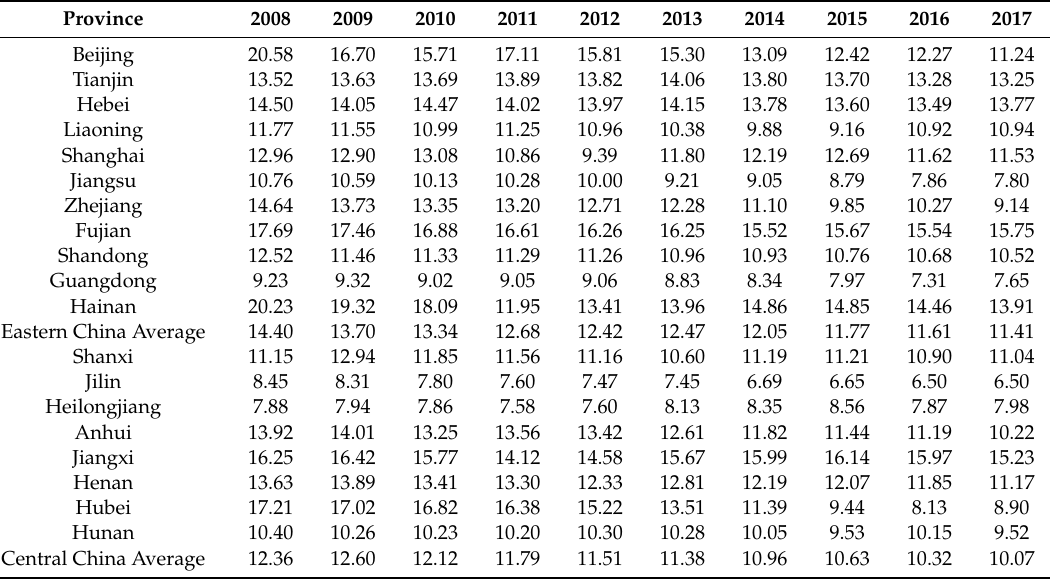
Table A2. 1998–2017 provincial hidden economy scale (%) (Part